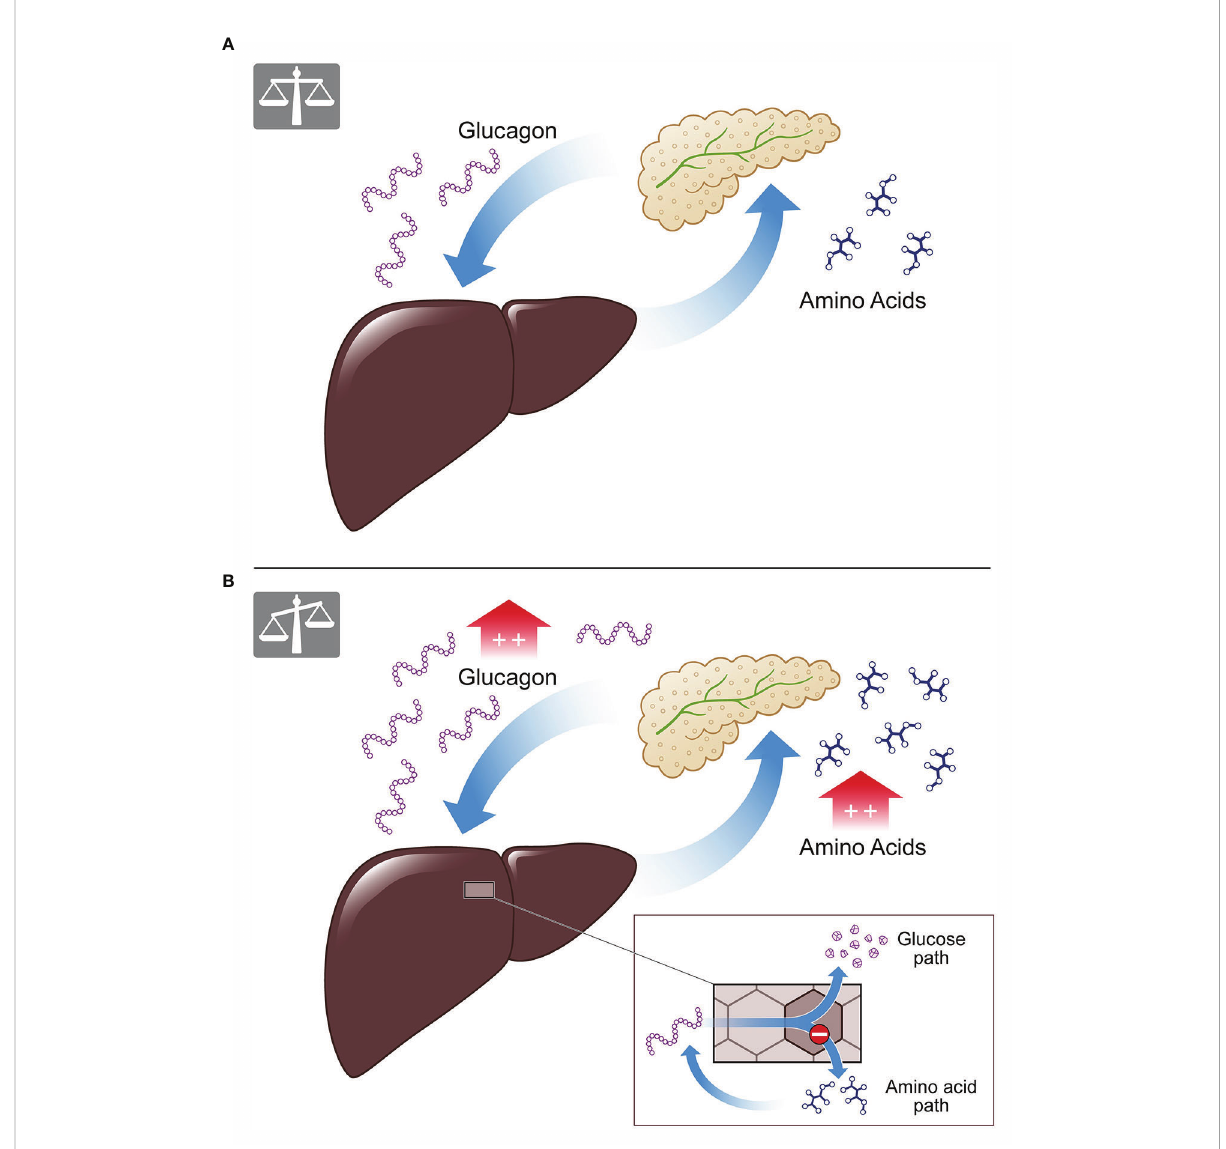
FIGURE 1 The liver-alpha cell axis. (A) Under physiological conditions amino acids lead to glucagon secretion from the pancreatic alpha cell, causing amino acid degradation and ureagenesis in the liver. The result is a balanced feedback cycle, termed the liver-alpha cell axis. (B) In conditions of metabolical impairment (e.g., NAFLD, T2D) the cycle is malfunctioning. Amino acids cannot be properly degraded as the amino acid pathway is disrupted, while the glucose pathway of glucagon is functioning (see insert). This results in hyperaminoacidemia and